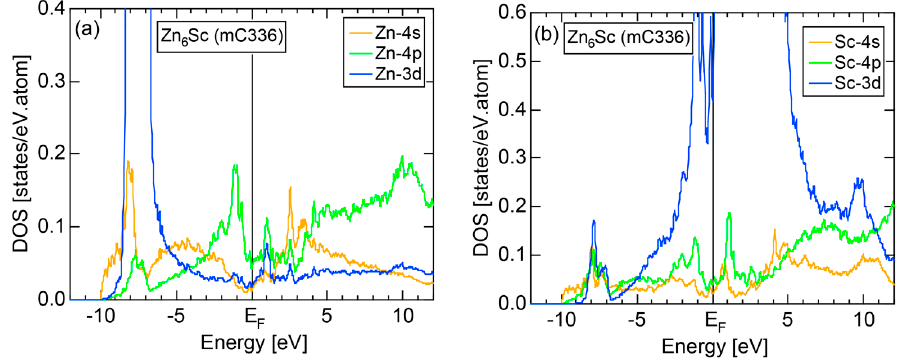
Figure 47. ( a ) Zn- and ( b ) Sc-pDOSs for Zn 6 Sc (mC336) [11,50]. (cid:68) (cid:69) The FLAPW-Fourier spectra , | C | 2 and the Hume-Rothery plot for Zn 6 Sc (mC336) are max E